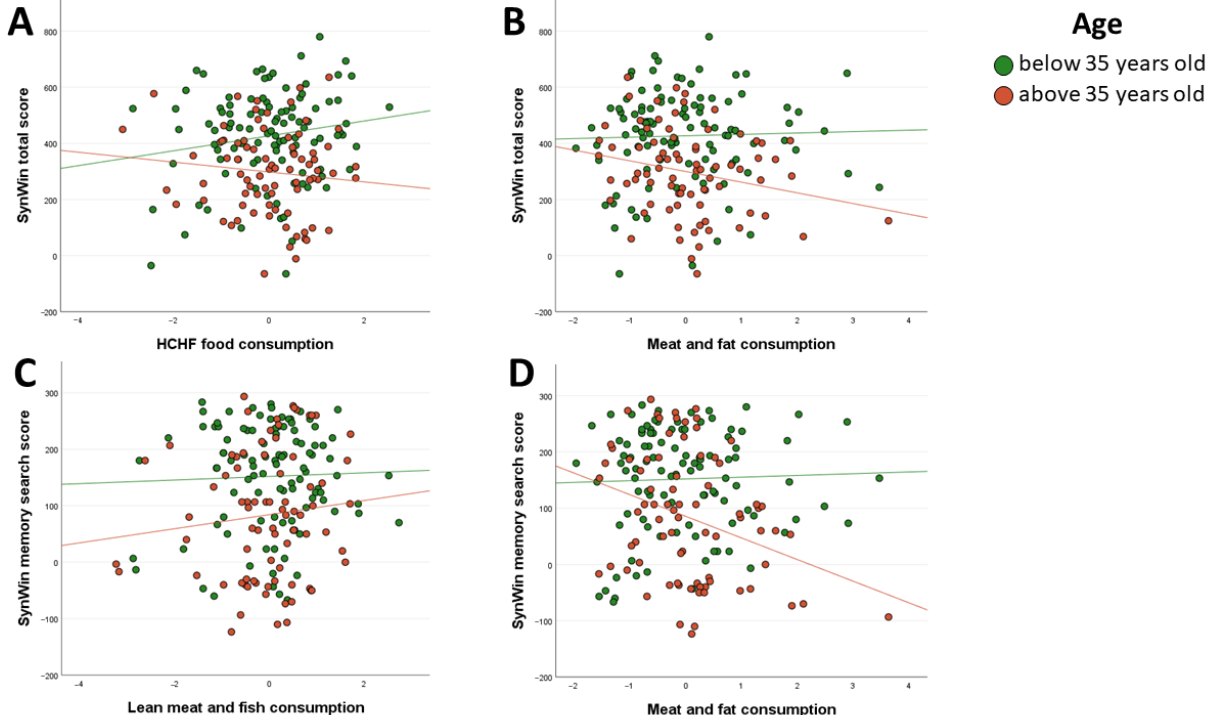
Figure 2. ( A ). Linear regression analyses of the associations between younger and older age groups and SynWin total score predicted by high-carbohydrates and high-fat (HCHF) consumption. ( B ). Linear regression analyses of the associations between younger and older age groups and SynWin total score predicted by meat and animal fat consumption. ( C ). Linear regression analyses of the associations between younger and older age groups and SynWin total score predicted by white meat and fish consumption. ( D ). Linear regression analyses of the associations between younger and older age groups and SynWin memory search score predicted by meat and animal fat consumption.